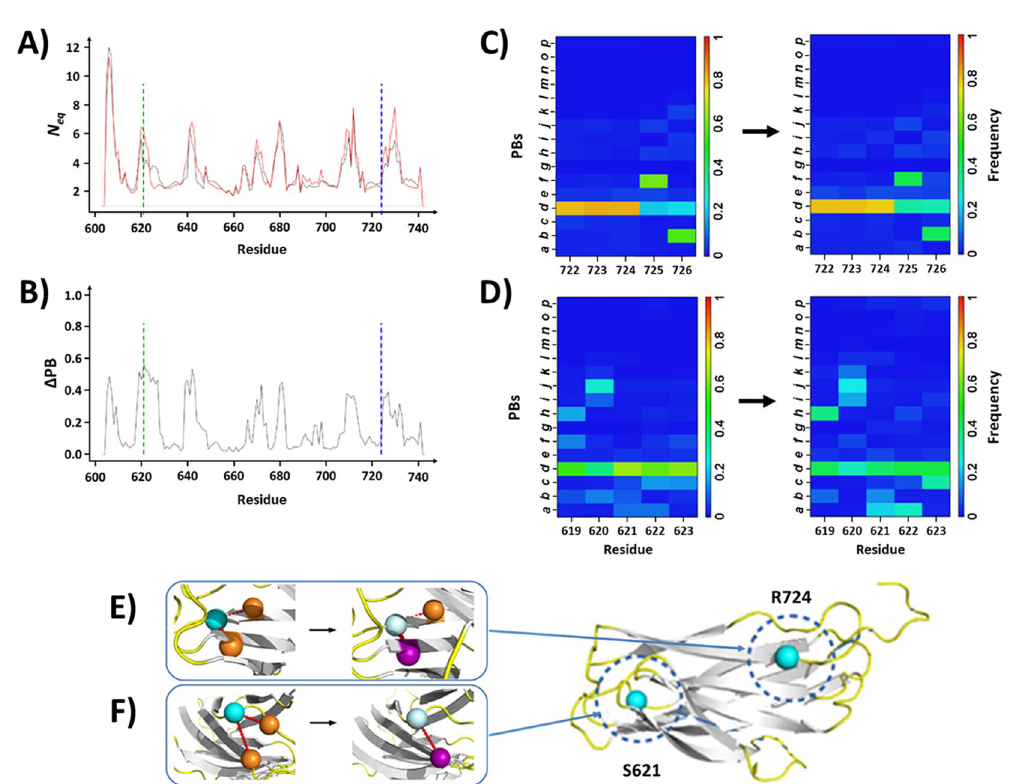
Figure 6. Variant R724Q. ( A ) N eq values of residues from the WT system (black curve) and of the R724Q variant (red curve). Positions of the residues 724 and S621 that presented the highest RMSF alteration are respectively indicated by blue and green dots lines. ( B ) Curve of the Δ PB values computed from the difference between the two systems. ( C ) PB maps from residues 722 to 726 for the WT (left) and the variant (right) systems. ( D ) PB maps for residues 619 to 623. Color scales indicate the frequency of occurrences of the PBs in the map. ( E ) Molecular interactions made by the residues 724 in the WT and the variant systems (left and right cartoons respectively). ( F ) Molecular interactions made by the residues 621 in the WT and the variant systems (left and right cartoons respectively). Residues 724 and S621 are shown as cyan balls in the WT form, and as light cyan balls the variant. Orange balls indicate residues that conserved their interactions with the residues 724 or S621 while magenta balls correspond to residues with modified interactions. A cartoon of the Calf-1 domain shows the respective locations of the residues 724 and